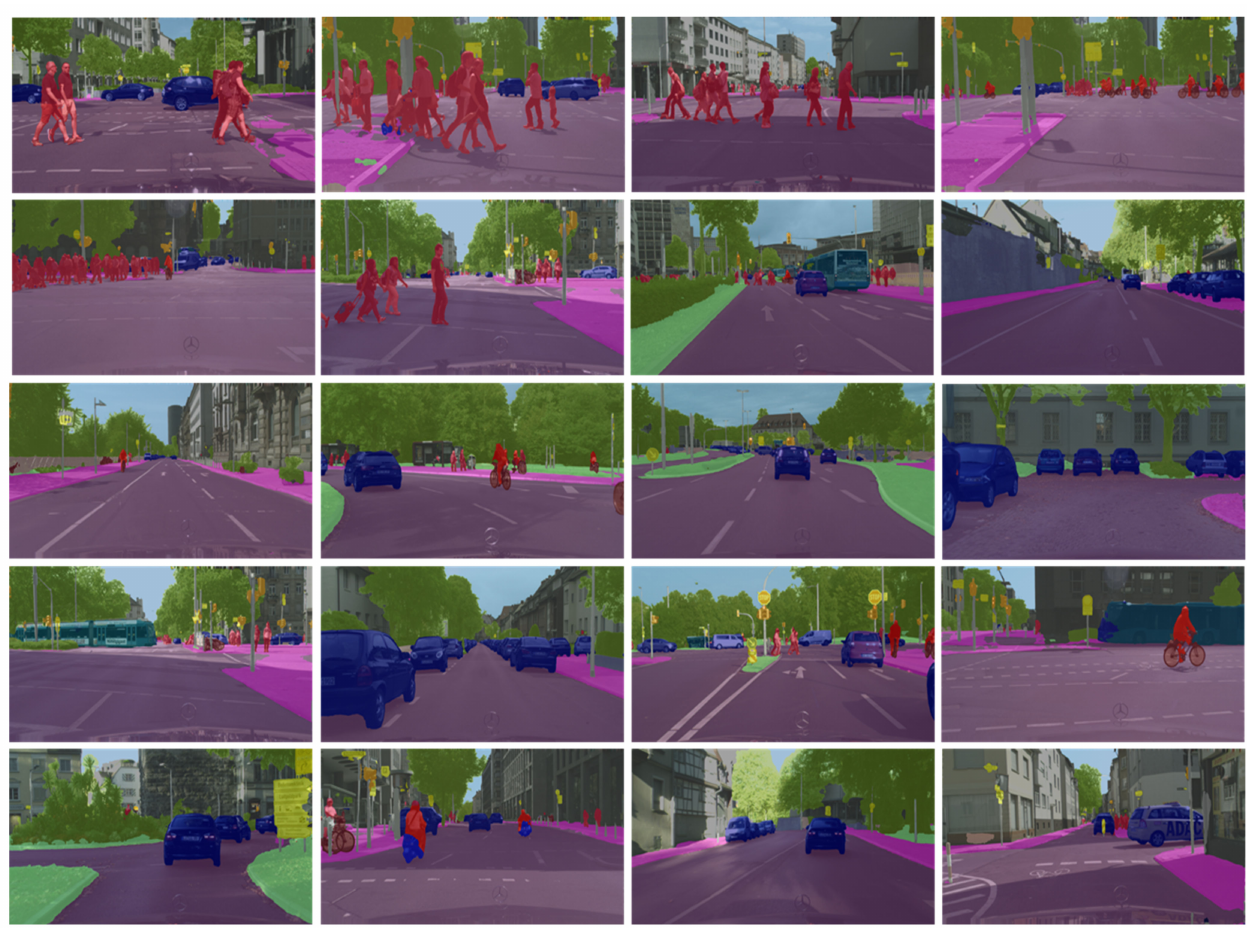
Figure 8. Segmentation results on Cityscapes by HFEN. We mask the prediction results over the original images to visualize the segmentation